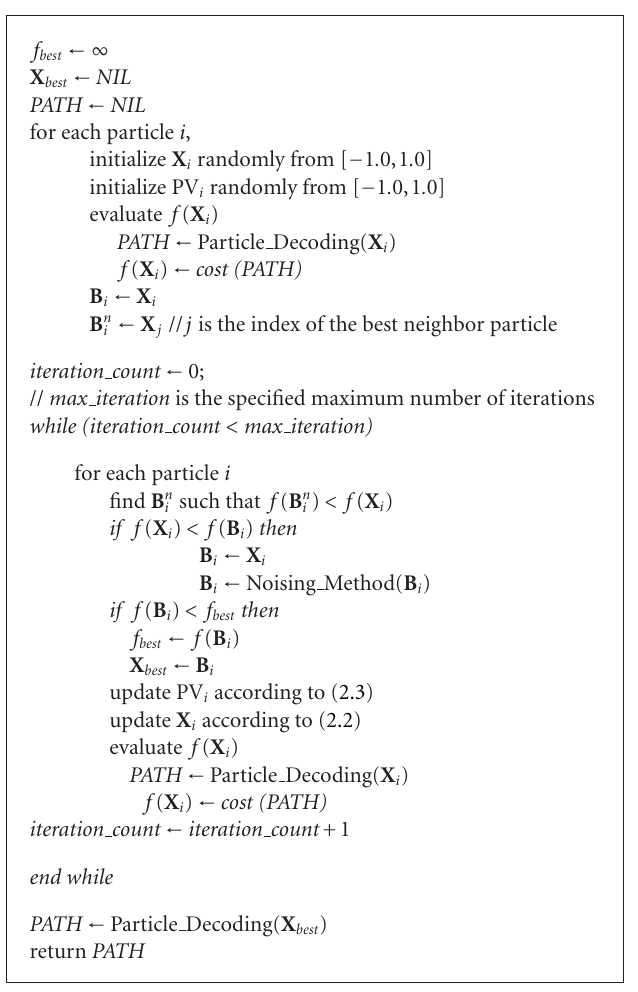
Algorithm 3 . 3 . Pseudo-codes for hybrid PSO (with CFM) and noising metaheuristics for the